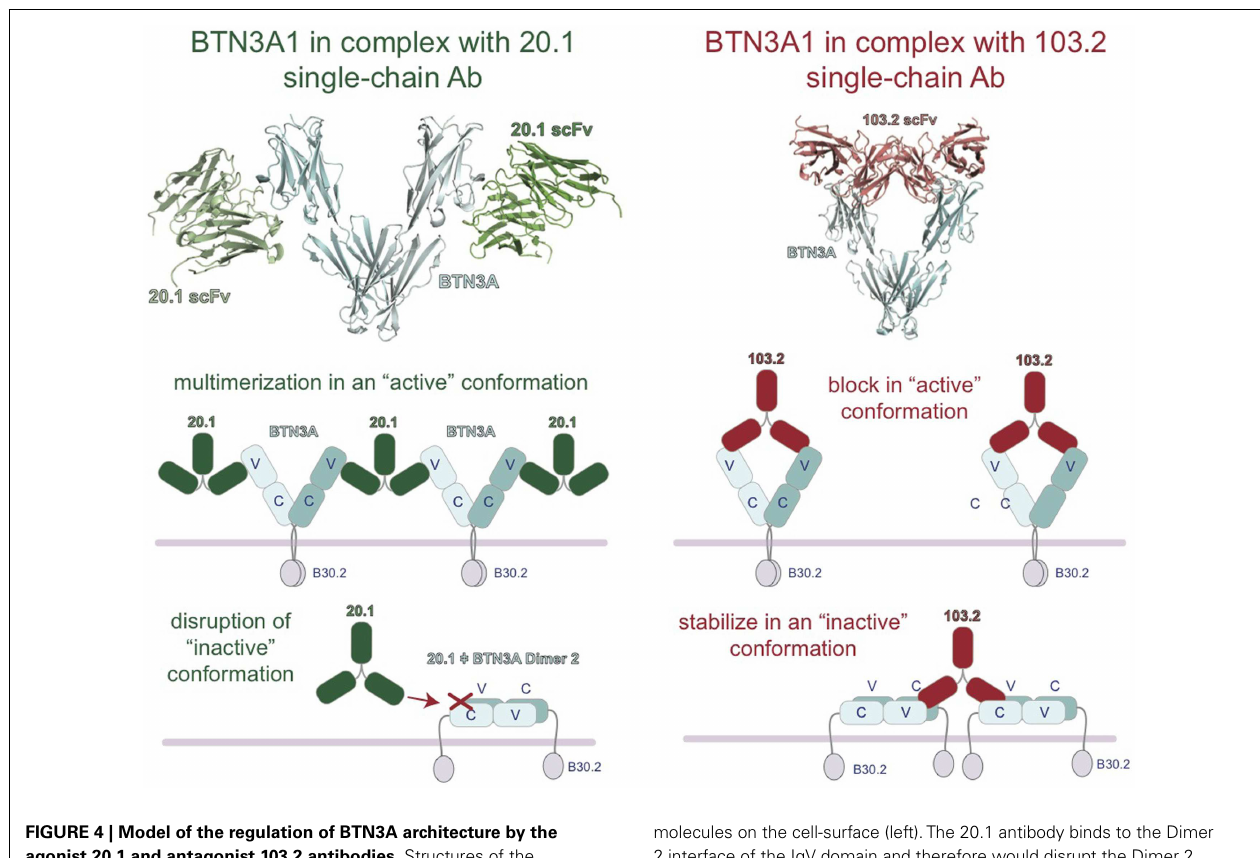
FIGURE 4 | Model of the regulation of BTN3A architecture by the agonist 20.1 and antagonist 103.2 antibodies . Structures of the extracellular domains of the BTN3A proteins (cyan) in complex with agonist (20.1, green) and antagonist (103.2, red) antibody single chains (scFv).The 20.1 antibody cannot “reach” across a BTN3A dimer 1 to occupy both binding sites and therefore is likely to multimerize BTN3A